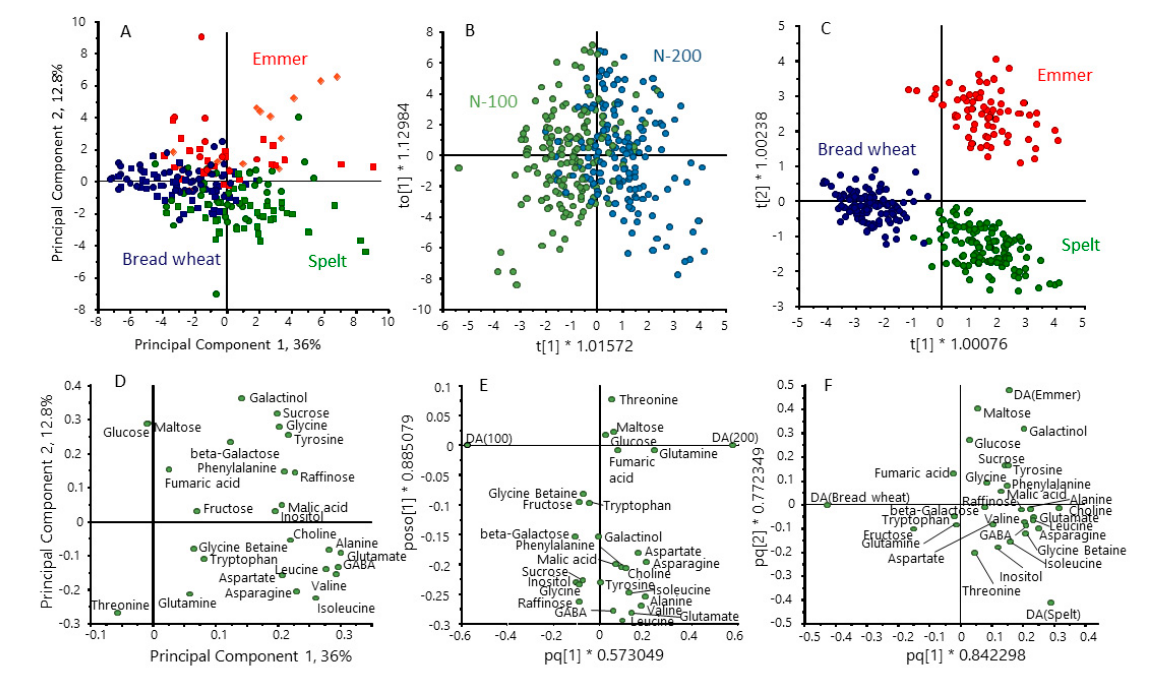
Figure 4. Multivariate analysis of the contents of polar metabolites in grains of the three cereal types grown in four environments. Principal component analysis PCA ( A ) and orthogonal partial least squares discrimination analysis (OPLS-DA) ( B , C ) selecting for differences between nitrogen treatments ( B ) and cereal types ( C ). ( D – F ) loading plots for ( A – C ), respectively. Colour code: red, emmer; green, spelt; blue, bread